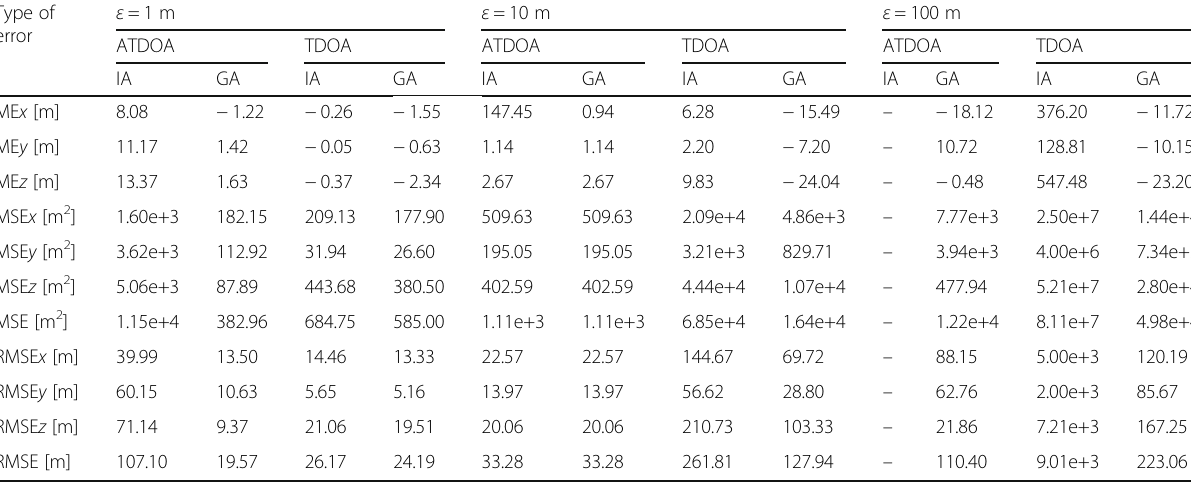
Table 1 Comparison of ME, MSE, and RMSE errors in the case under consideration. The ε represents the ε ATDOA or ε TDOA in the adopted simulation